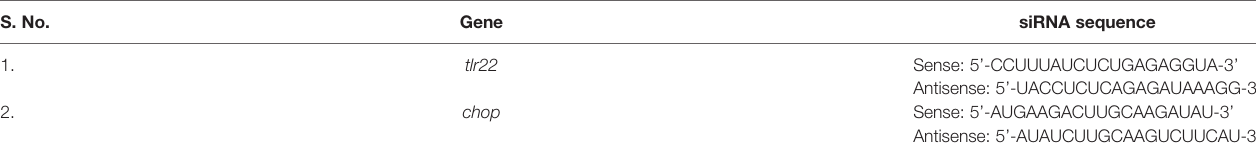
TABLE 1 | List of